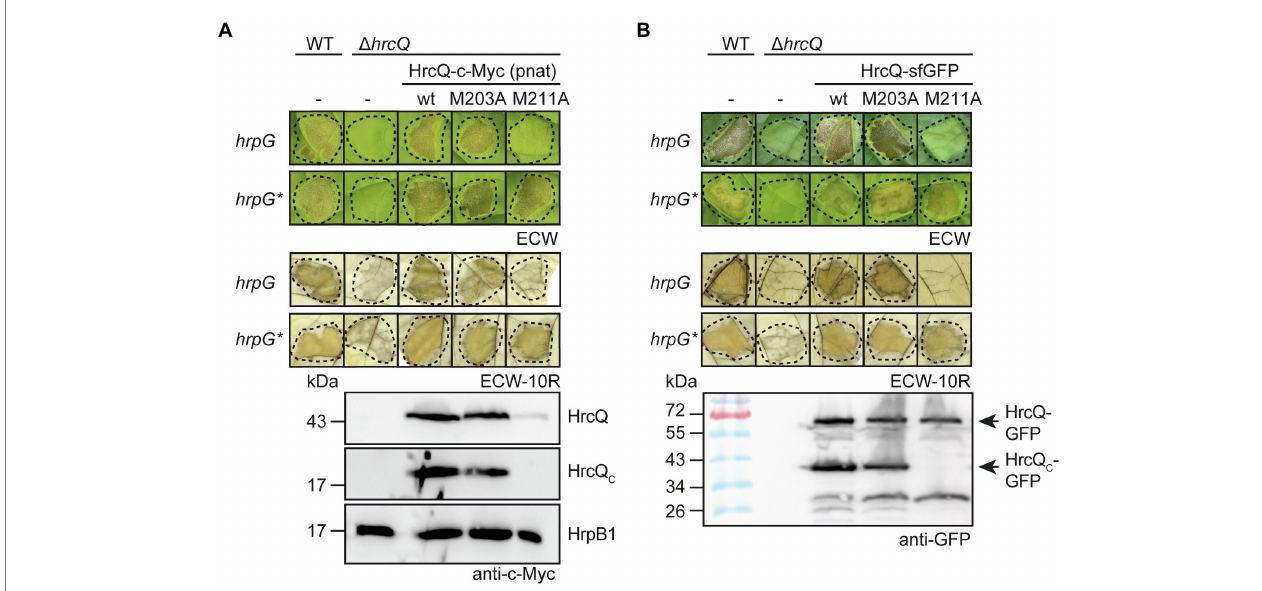
FIGURE 2 | The predicted internal translation start site at codon position 211 of hrcQ contributes to pathogenicity of X. campestris pv. vesicatoria . (A) A HrcQ derivative with an M211A mutation does not restore pathogenicity in strain 85–10 ∆ hrcQ. Xanthomonas campestris pv. vesicatoria strains 85–10 (WT, hrpG ), 85* (WT, hrpG* ) and hrcQ deletion mutant derivatives ( ∆ hrcQ ) thereof without plasmid ( − ) or with expression constructs encoding HrcQ-c-Myc (wt), HrcQ M203A -c-Myc (M203A) or HrcQ M211A -c-Myc (M211A) under control of the native promoter as indicated were infiltrated into leaves of susceptible Early Cal Wonder (ECW) and resistant ECW-10R pepper plants. Disease symptoms were photographed 8 dpi. For the better visualization of the HR, leaves were bleached in ethanol 2 dpi. Dashed lines indicate the infiltrated areas. For the analysis of HrcQ proteins, bacteria were grown in minimal medium and equal amounts of cell extracts were analyzed by immunoblotting using a c-Myc epitope-specific antibody. The blot shows the extracts of hrpG* strains and was reprobed with an antibody specific for the predicted inner rod protein HrpB1 to demonstrate equal loading. (B) The M211A mutation in a HrcQ-sfGFP fusion protein interferes with protein function. Strains 85–10, 85*, and hrcQ deletion mutant derivatives thereof without plasmid ( − ) or containing expression constructs encoding HrcQ-sfGFP fusions with or without M203A or M211A mutations were infiltrated into leaves of susceptible and resistant pepper plants. Disease symptoms and the HR were monitored as described in (A) . For protein detection, equal amounts of cell extracts were analyzed by immunoblotting using a GFP-specific antibody. Arrows indicate the size of HrcQ-GFP and HrcQ C -GFP. Experiments were performed three times with similar